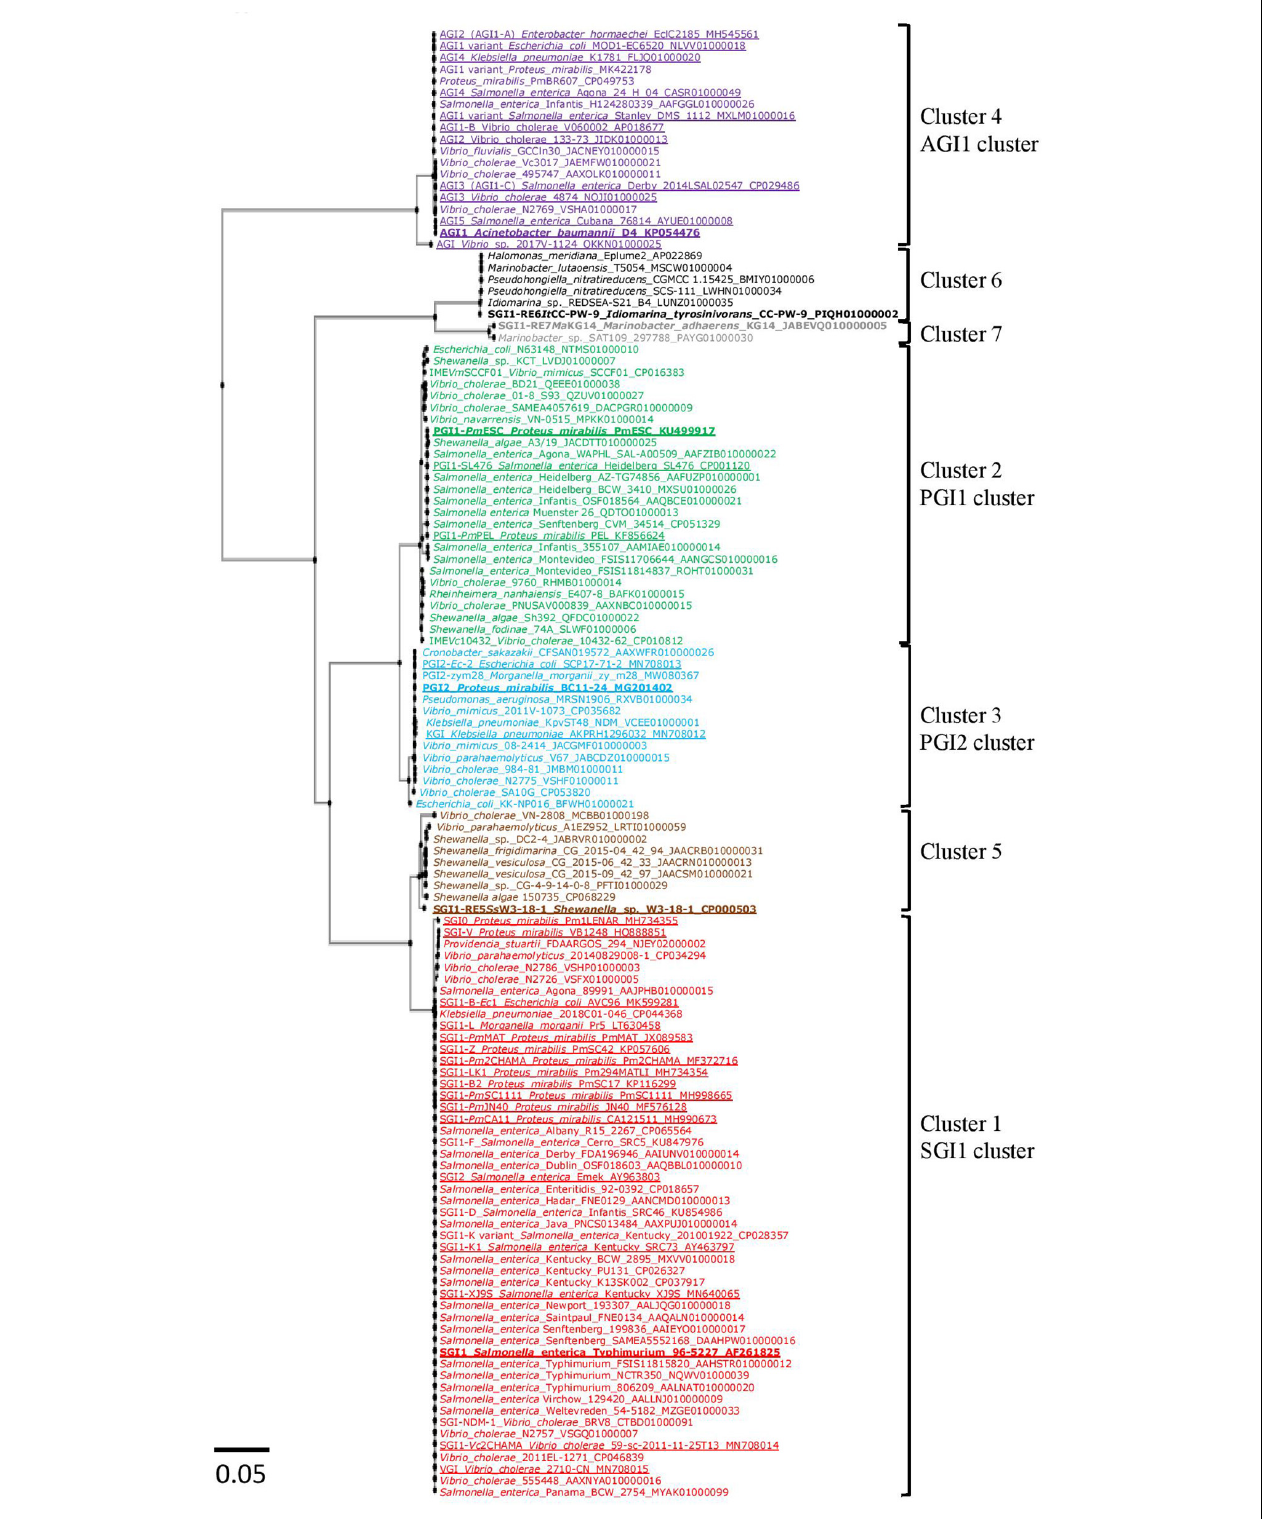
FIGURE 1 | Phylogenetic tree of int genes of SGI1-REs included in this study. The colors of the strains correspond to the clusters of Salmonella genomic island 1-related elements (SGI1-REs): red (cluster1: SGI1 cluster), green (cluster 2: PGI1 cluster), blue (cluster 3: PGI2 cluster), purple (cluster 4: AGI1 cluster), brown (cluster 5), black (cluster 6), and gray (cluster 7). The characterized SGI1-REs are underlined, and the SGI1-REs used as a reference are in bold.